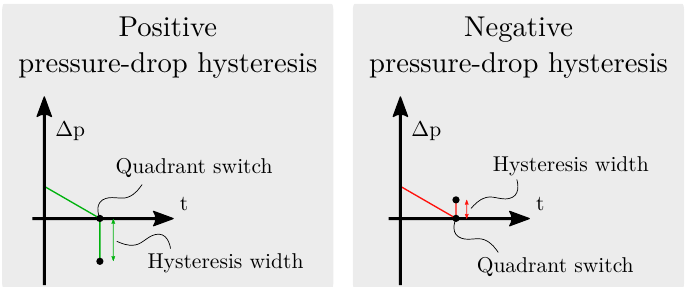
Figure 10. Visualisation of pressure-drop hysteresis. Here, the pressure difference is linearly de- creasing from a positive value to zero. At zero, there is a quadrant switch. If the pressure difference then is moved further down, it corresponds to positive pressure-drop hysteresis. If the switch causes the pressure difference to move back into the positive ∆ p -region, it corresponds to negative pressure-drop hysteresis.